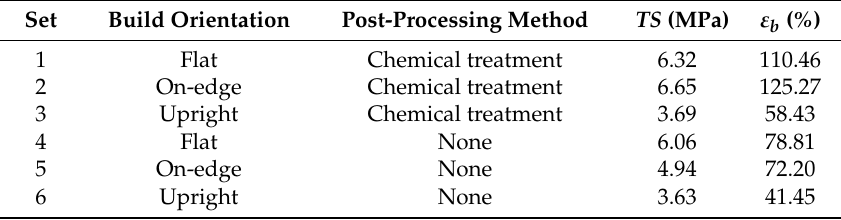
Table 5. Average tensile test results of specimens with and without post-processing.